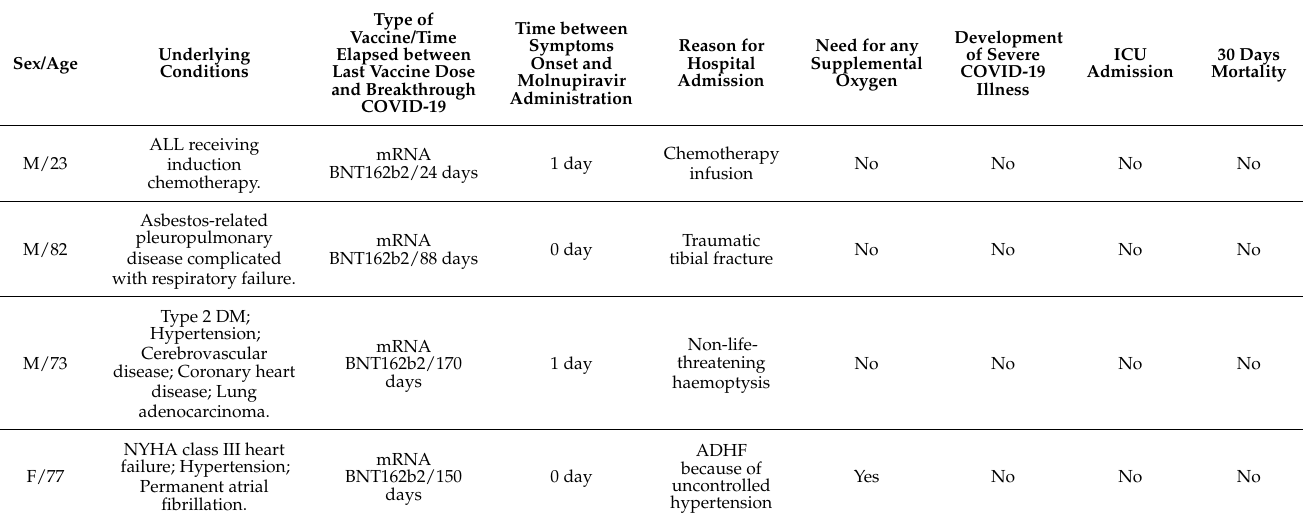
Table 2. Clinical characteristics and outcomes of patients with breakthrough COVID-19 who required hospital admission after molnupiravir